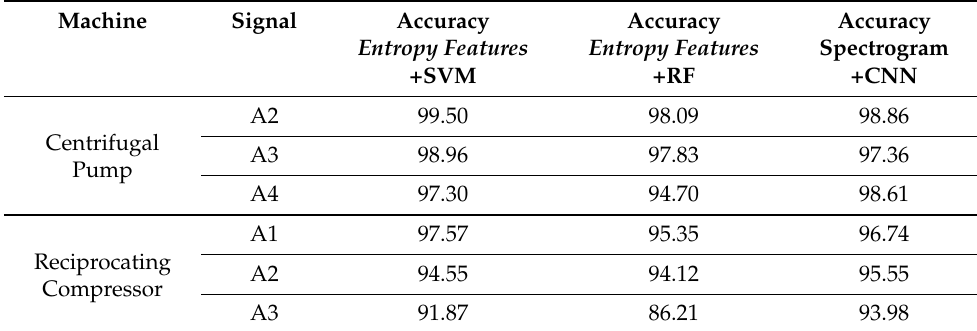
Table 7. Comparison of performances of the tested models obtained during the 10-fold cross- validation between entropy features with classical models and the spectrogram with a CNN